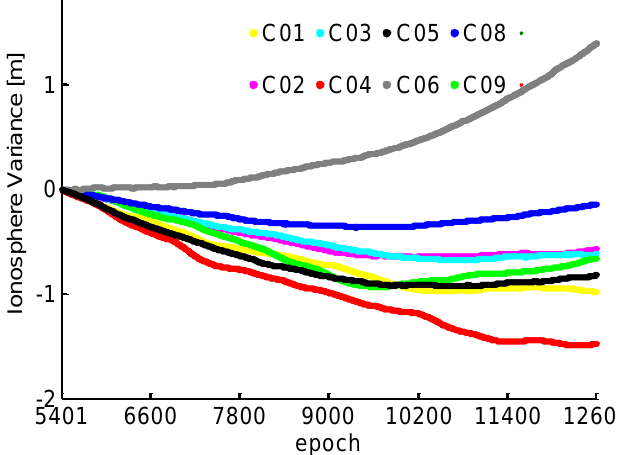
Figure 4. Relative ionospheric delay variation values.